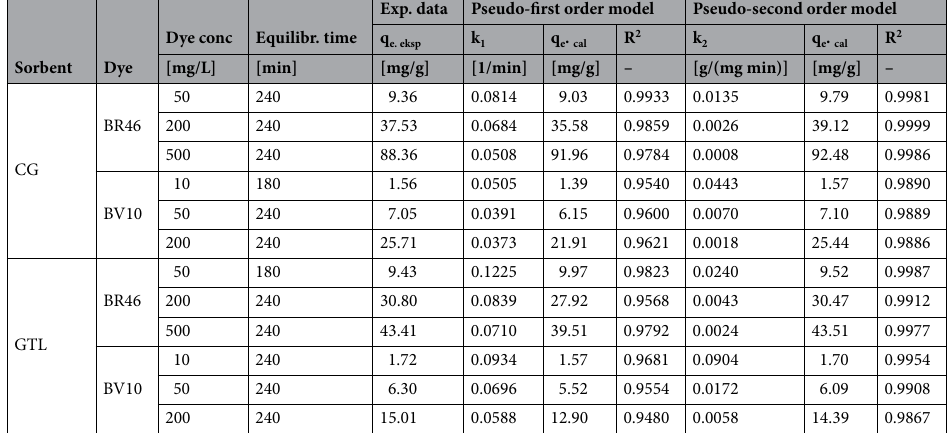
Dye conc Equilibr. Sorbent Dye